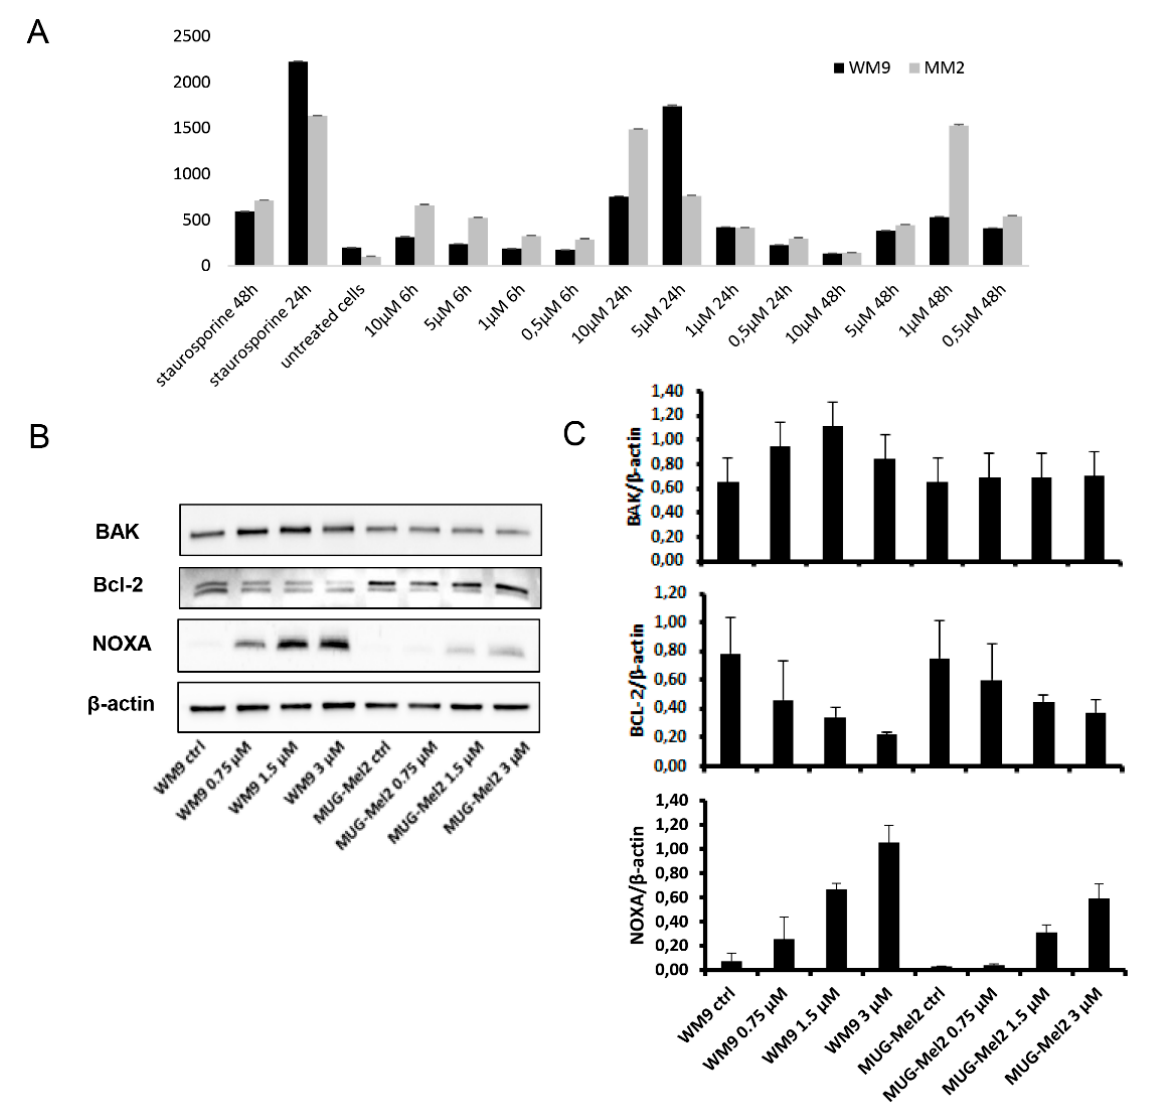
Figure 4. Apoptotic induction by treatment with SK119. ( A ) Results of the Caspase ‐ Glo ® 3/7Assay. Treatment of WM9 and MUG-Mel2 cells led to a strong activity increase in caspases 3/7, indicative of apoptosis induction 24 h after treatment (mean ± SD, n = 6). Staurosporine (25 µ M) served as positive control; ( B ) Western blot analyses were used to verify the expression of the pro-apoptotic BAK, the anti ‐ apoptotic Bcl ‐ 2 and the antagonist NOXA at the protein level. One representative blot out of three is shown and β‐ actin was used as loading control; ( C ) Densiometric quantification are presented (mean ± SD; n = 3). All full ‐ length blots are presented in the Supplementary Materials, Figure S12.